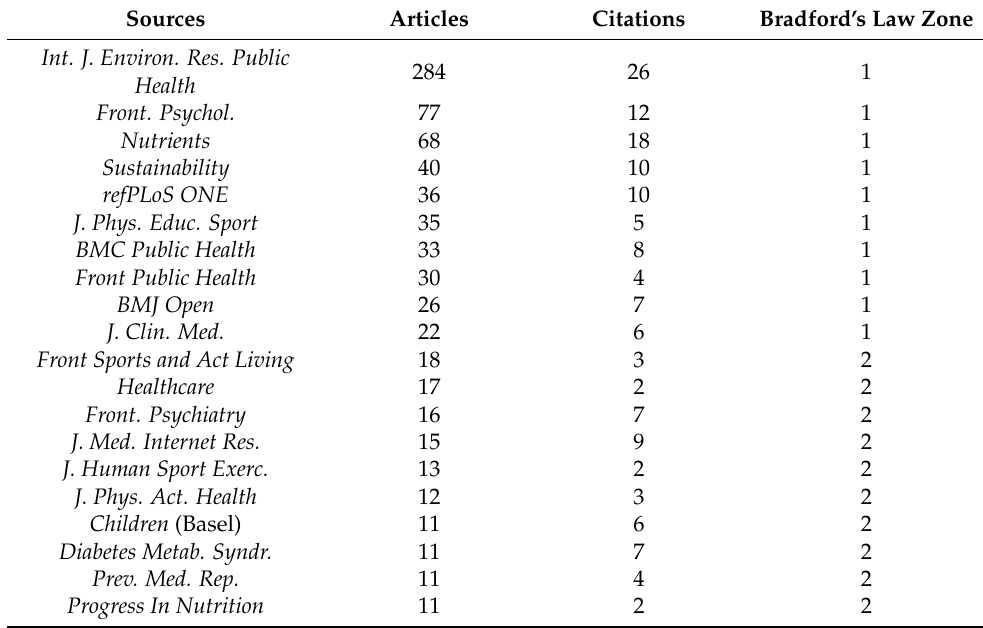
Table 3. Most productive journals on physical activity and coronavirus disease (2020–2021).